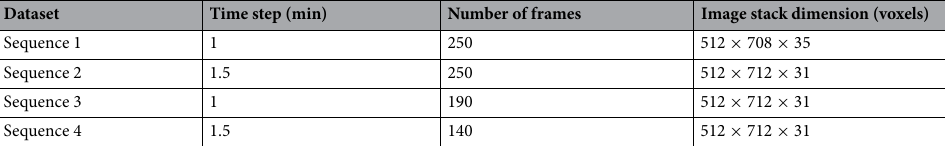
Table 4. C. elegans developing embryo nuclei dataset 31,32 . The resolution of each image stack is 0.09 µ m × 0.09 µ m × 1.0 µ m . Sequence 1 and 2 are training set which contains partial nuclei segmentation with track IDs for training. Sequence 3 and 4 are testing set so no annotations